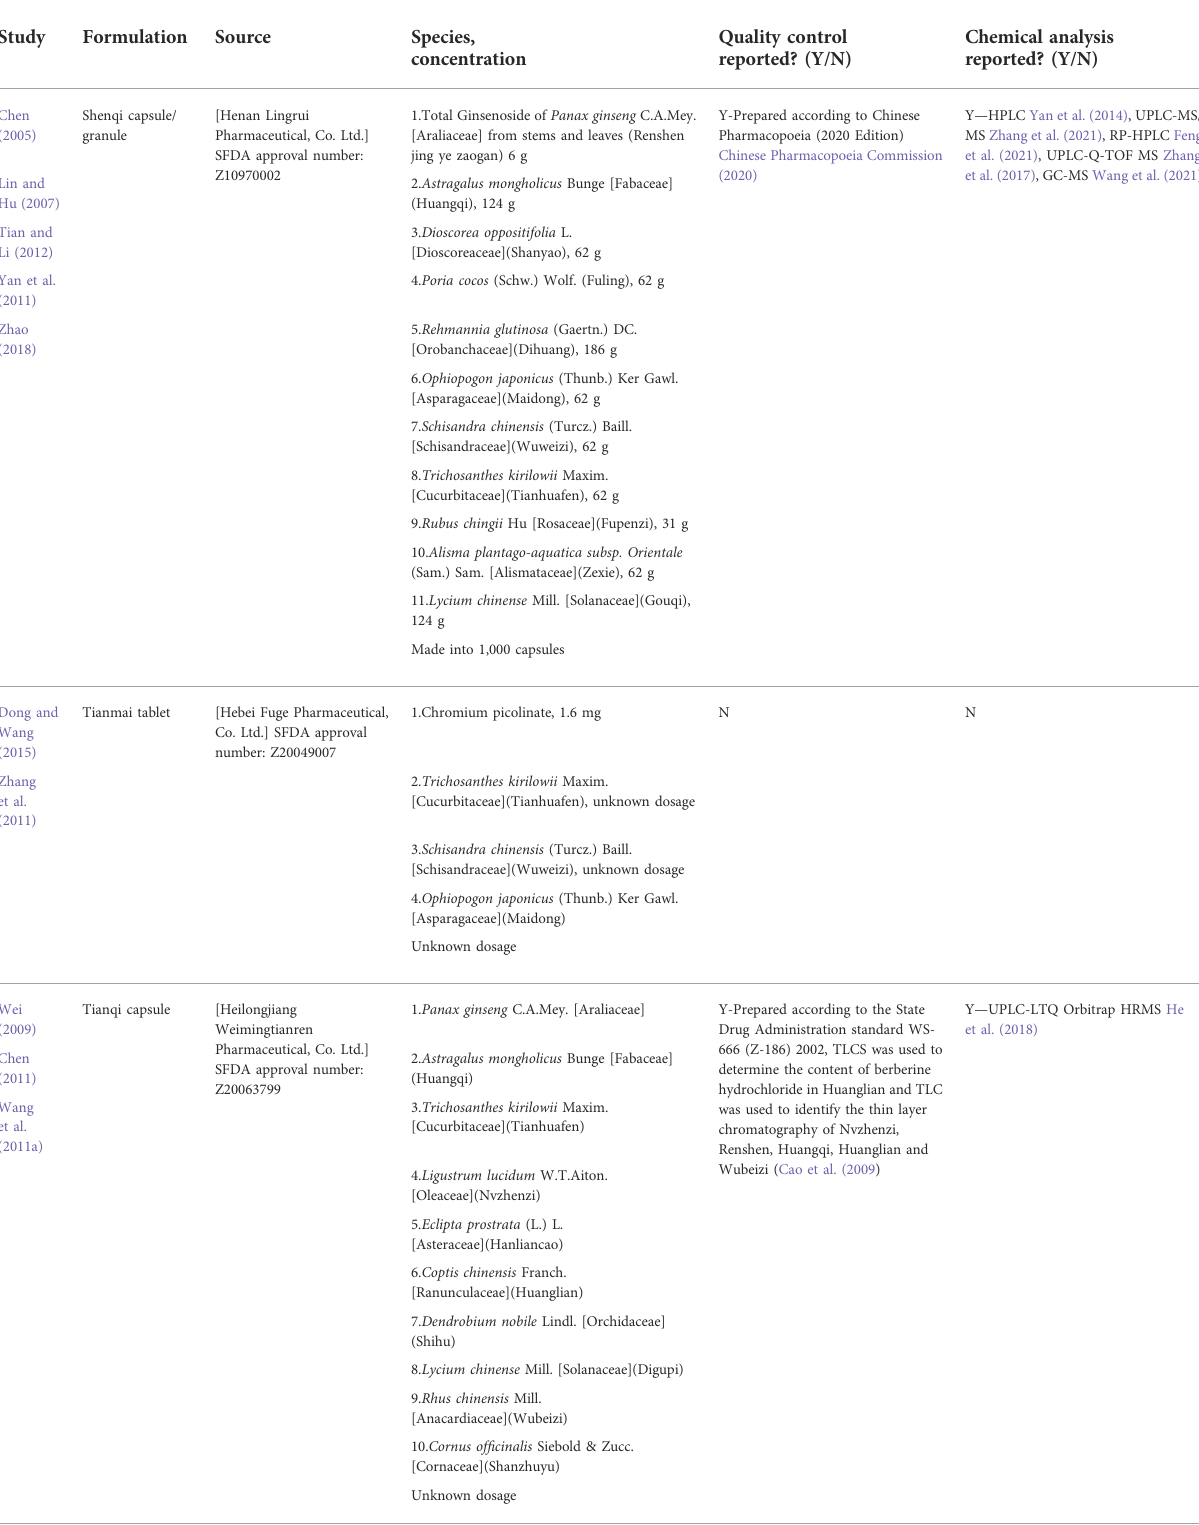
TABLE 2 Patented formulations of the Included